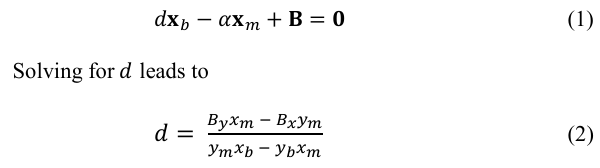
to in the case 𝐈𝐈 𝑢𝑢 , 𝑣𝑣 𝐈𝐈 𝑟𝑟 , 𝜃𝜃 is 𝐴𝐴 𝑑𝑑